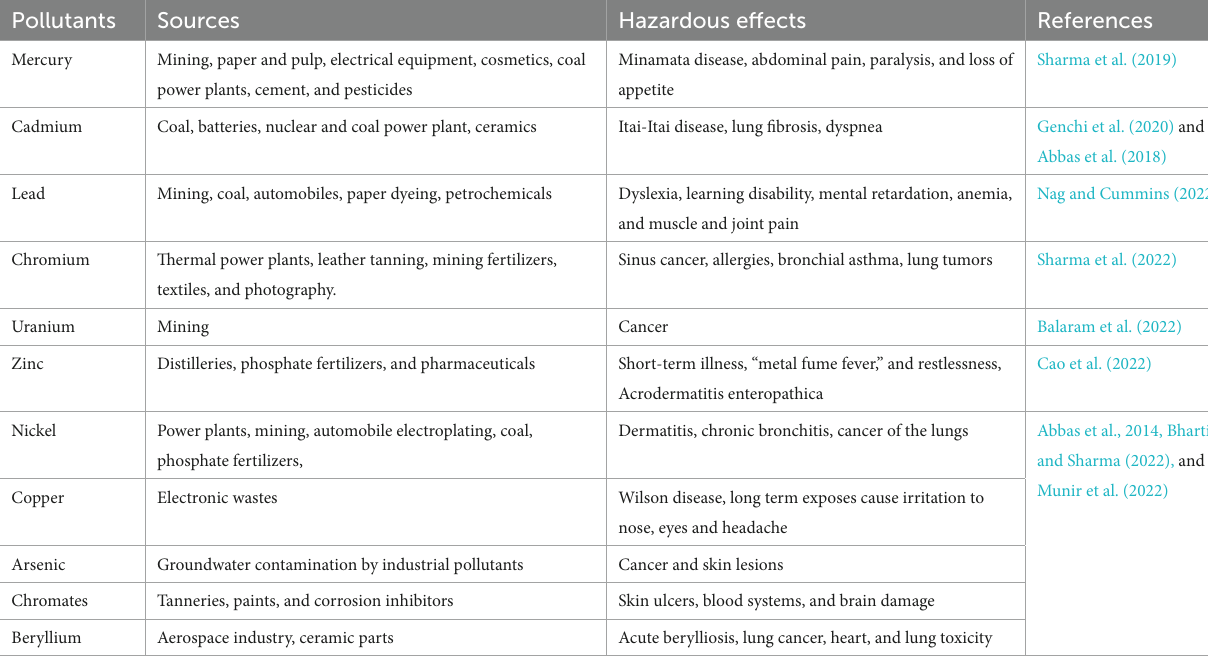
TABLE 1 Sources and toxic impacts of heavy